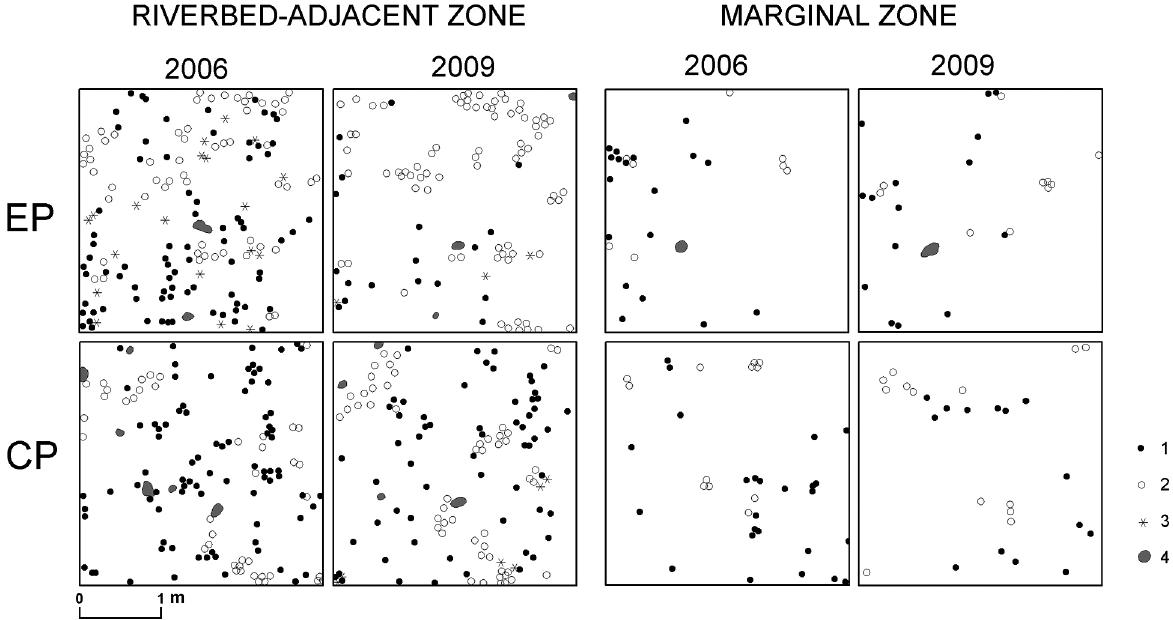
Fig. 6. Influence of 3 years mowing on wet meadow species occurrence in sedge communities in different parts of the Chwiszczej river valley. Distribution of aboveground shoots of Lysimachia vulgaris (1), Lythrum salicaria (2), Stachys palustris (3) and Filipendula ulmaria (4) on mown (EP) and unmown (CP) quadrates is presented in the